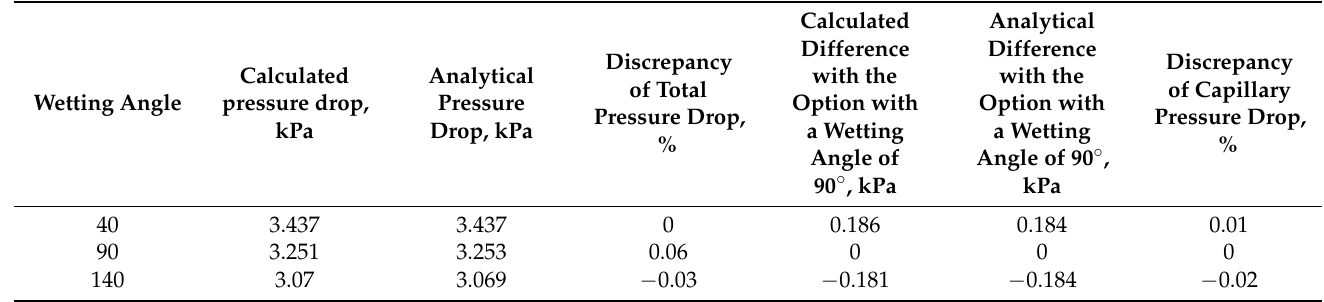
Table 1. Total and capillary pressure drop along the length of the microchannel depending on the wetting angle at a time of 1.5 s.